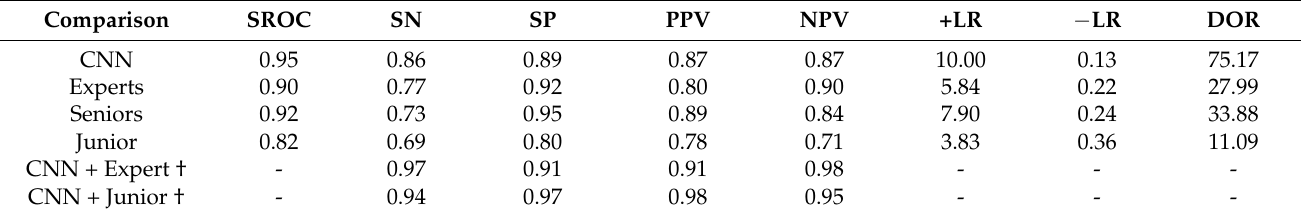
Table 4. Comparison between deep learning and